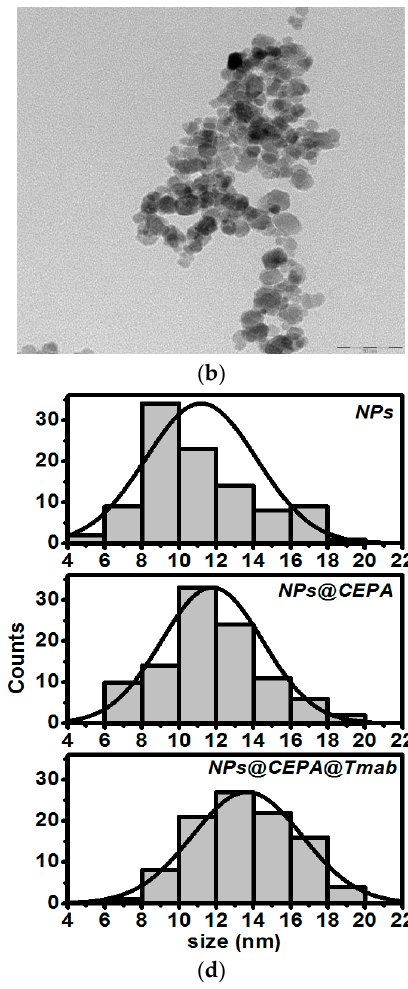
Table 1. Values of average hydrodynamic diameter and zeta potential